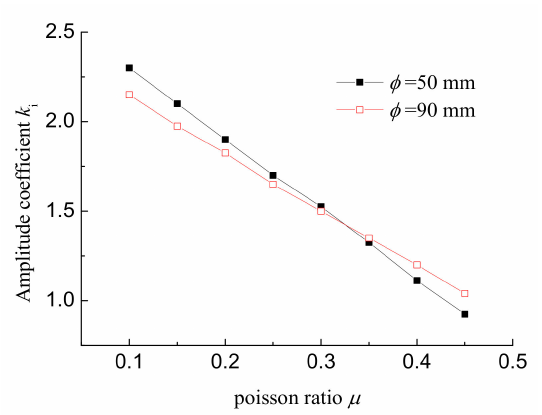
Figure 9. Relationship between Poisson’s ratio and amplitude coefficient.